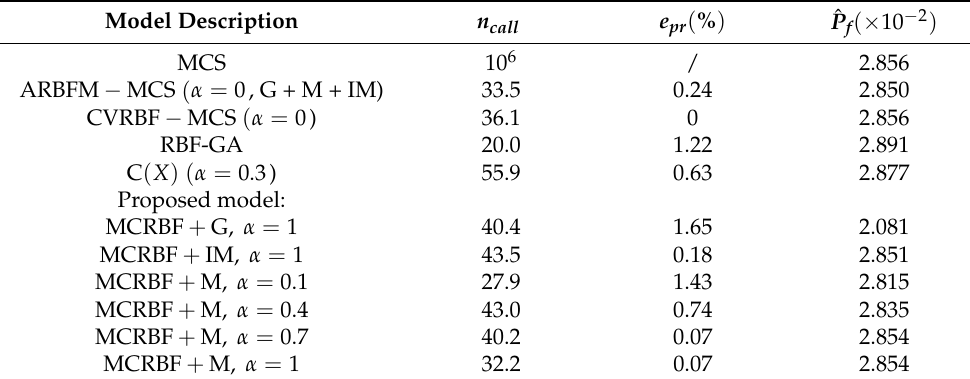
Table 4. The results for example 2.